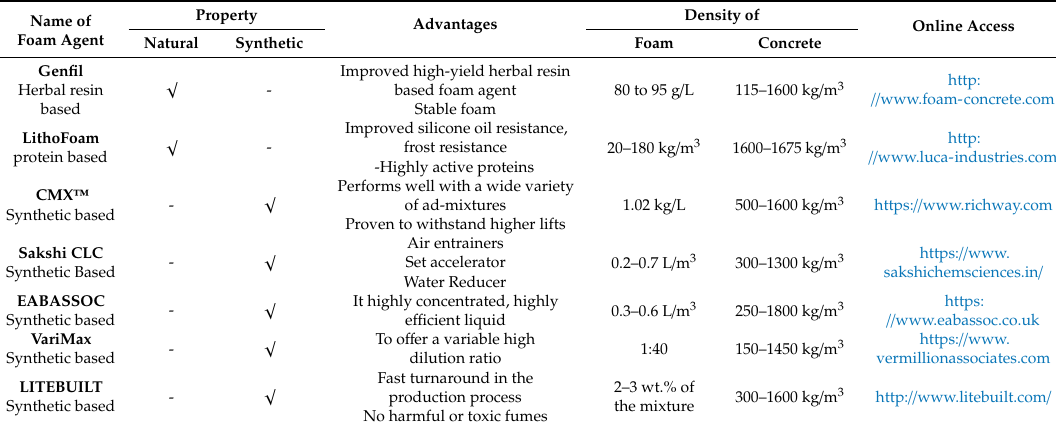
Table 1. Various foam agents are available in E-markets